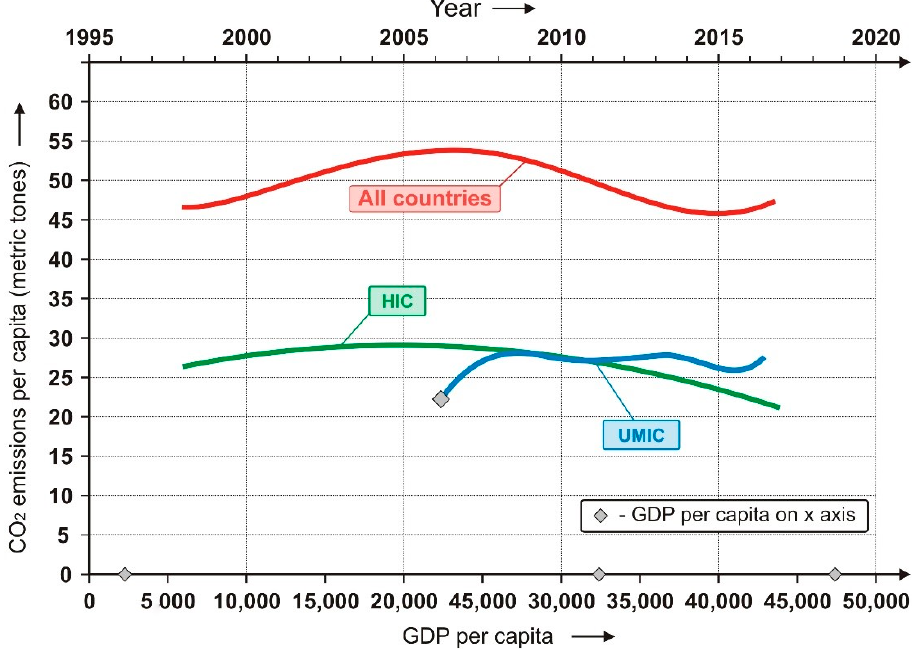
Figure 6. Relationship between CO 2 emissions per capita and GDP per capita summary for all Balkan countries, and HIC and UMIC groups (1998–2019) (Authors’ creation). Table 5. Pearson correlation coefficient for FDI and CO 2 emission presented per country and for all countries, HIC and